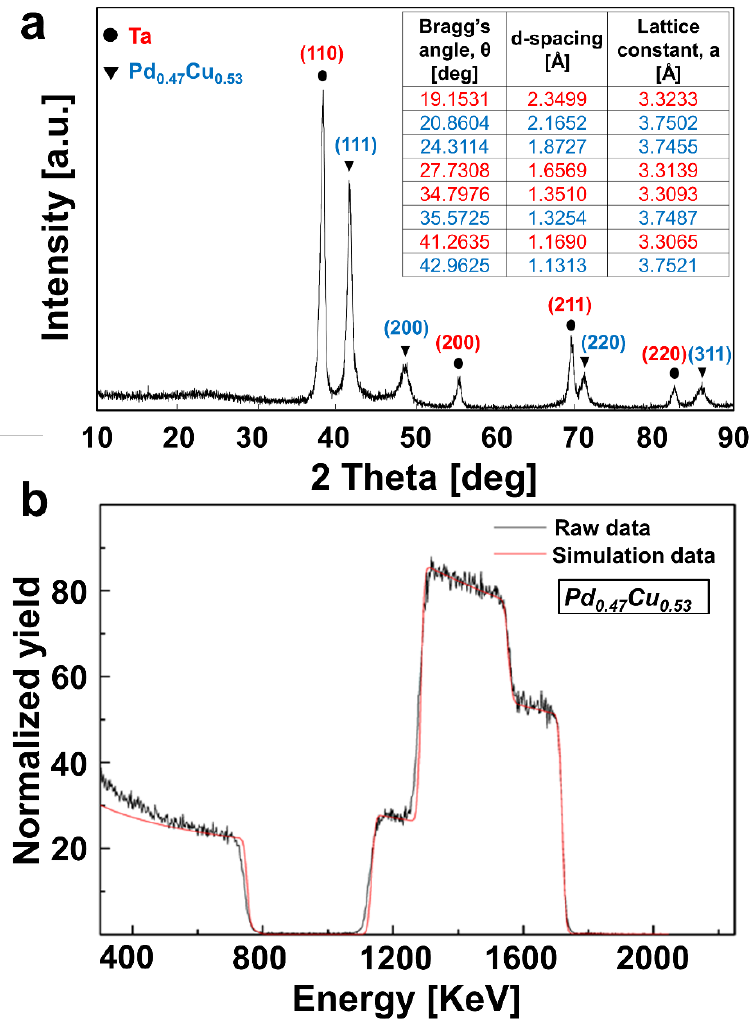
Figure 6. PdCu(co‑SPT)/Ta characterization by ( a ) XRD and ( b ) Figure 6. PdCu(co-SPT)/Ta characterization by ( a ) XRD and ( b ) RBS.